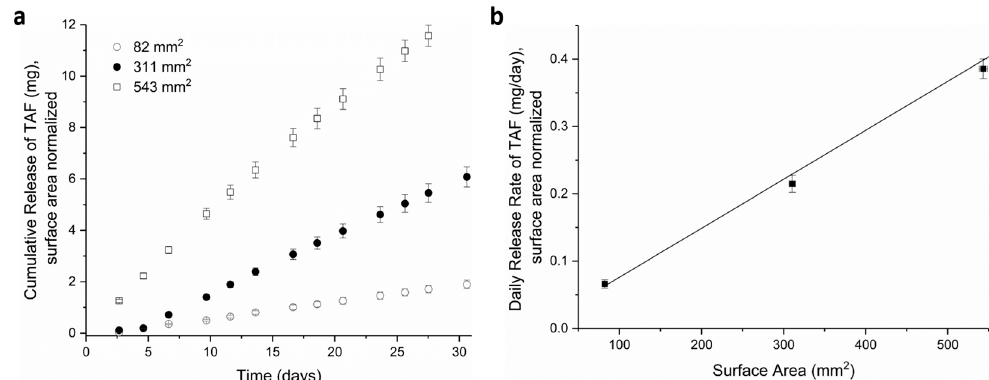
Figure 2. In vitro release studies showing ( a ) cumulative release of TAF from implants of differing surface areas and ( b ) daily release rates of TAF at day = 24 for implants with different surface areas. All implants were fabricated with Sigma-PCL, 100 µm wall thickness and a formulation of 2:1, TAF:castor oil. Surface areas were normalized according to the theoretical surface area for implant of 10, 40, 70 mm in length. Three implants were tested per condition.